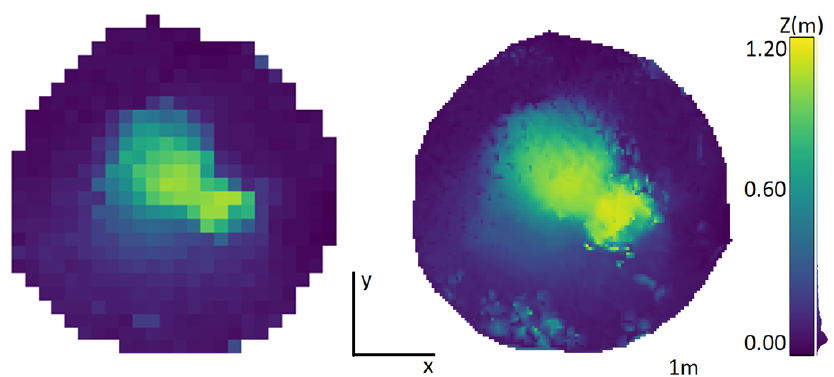
Figure 6. To estimate termite mound height, a large grid size was used to avoid the influence from outliers ( left ). To calculate volume, a smaller grid size was used. Since the volume was calculated as the sum of many small cuboids, possible outliers had less influence ( right ).